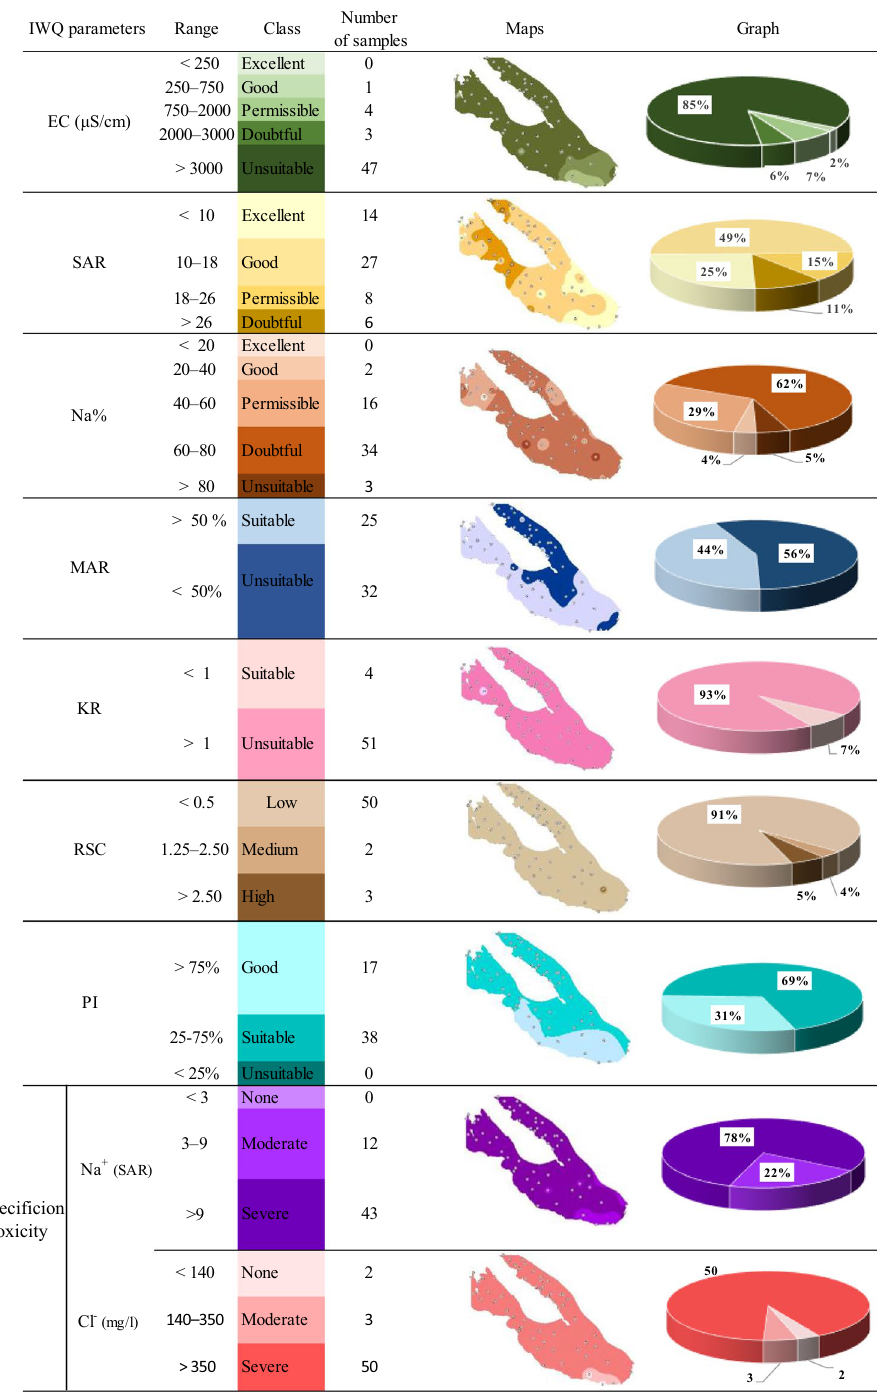
Table 8 Classification of groundwater samples based on irrigation water quality (IWQ)